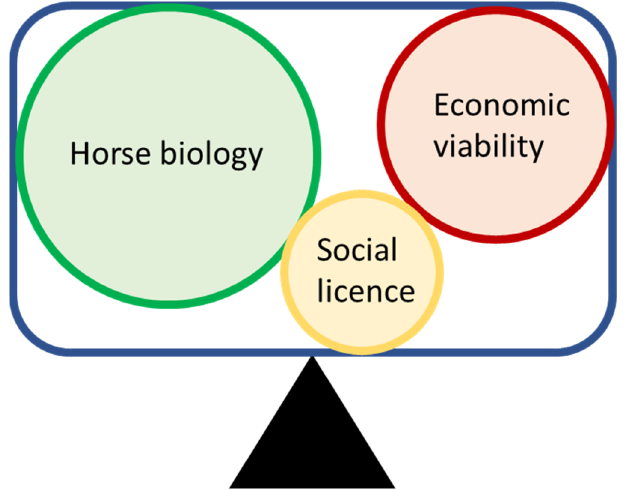
Figure 1. Conceptual schema of the bioeconomic constraints of a racing jurisdiction in equilibrium— alter one moderator and the whole system needs re-adjustment to establish equilibrium. Different jurisdictions would have different weightings for each of the three moderators.